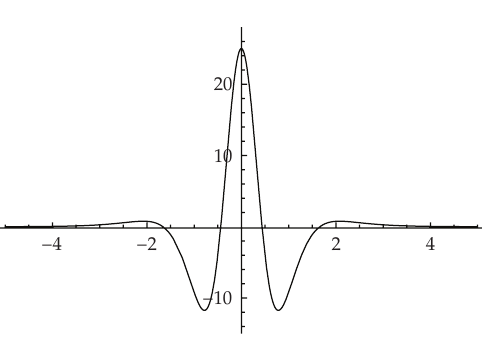
Figure 3: Graph of the fractional derivative u 3 . 8 (cid:3) X (cid:4)